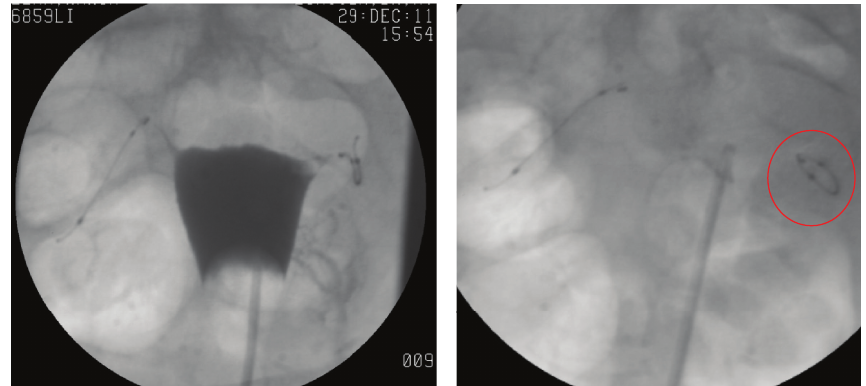
Figure 1: Post-Essure hysterosalpingogram (HSG) (12/29/11): no spillage is noted on either side, which confirms bilateral tubal occlusion, while showing the left Essure coil microinsert twisted in an abnormal configuration (red circle), which does not seem to follow the expected anatomic trajectory of the fallopian tube. Instead, it appears curved on itself in an elliptical fashion.